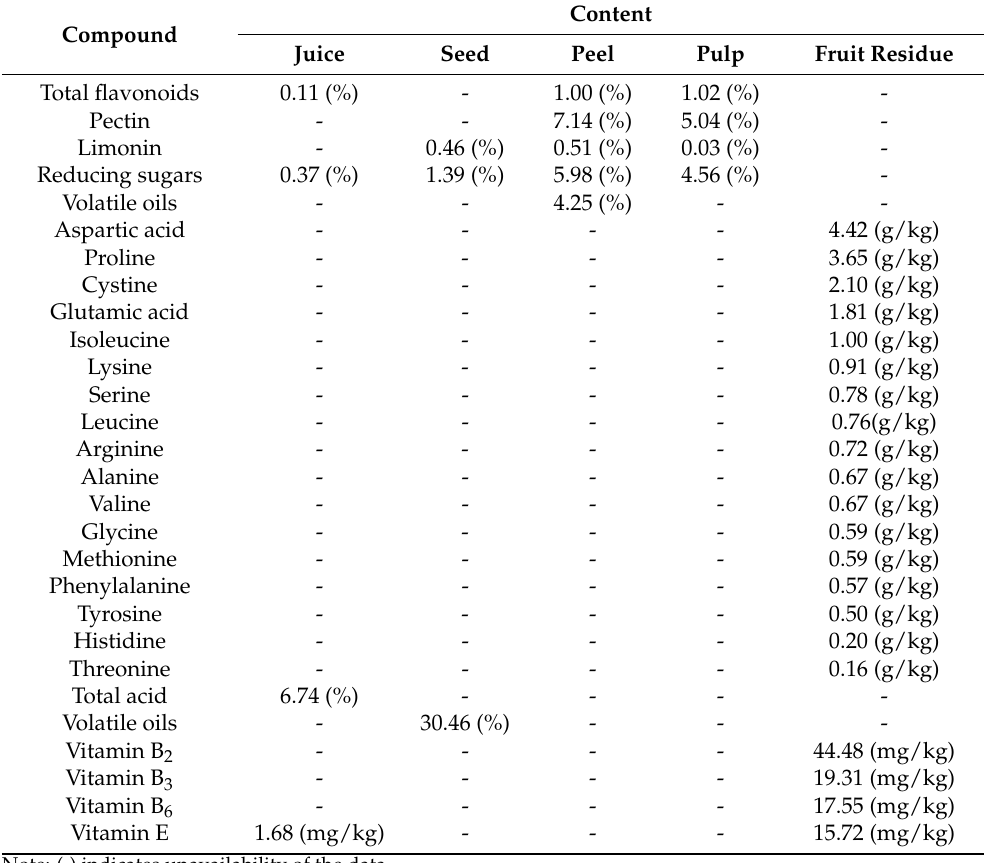
Table 1. Chemical composition of various parts of calamondin fruit [8].